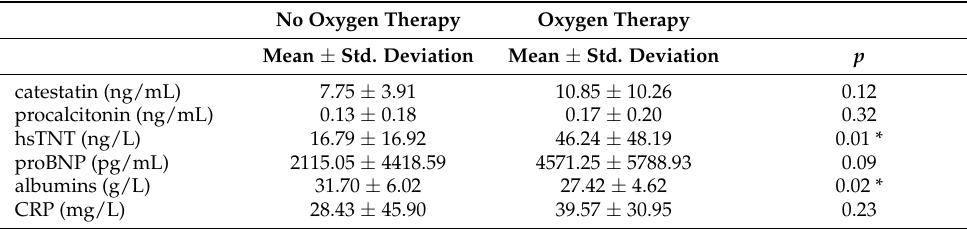
Table 5. Differences between participants on oxygen therapy ( n = 12) and participants without oxygen therapy during hospitalization ( n = 20) in CST and cardiovascular and inflammatory parameters (Student’s t -test, one-tailed). No Oxygen Therapy Oxygen Therapy Mean ± Std. Deviation Mean ± Std. Deviation p catestatin (ng/mL) 7.75 ± 3.91 10.85 ± 10.26 0.12 procalcitonin (ng/mL) 0.13 ± 0.18 0.17 ± 0.20 0.32 hsTNT (ng/L) 16.79 ± 16.92 46.24 ± 48.19 0.01 * proBNP (pg/mL) 2115.05 ± 4418.59 4571.25 ± 5788.93 31.70 ± 6.02